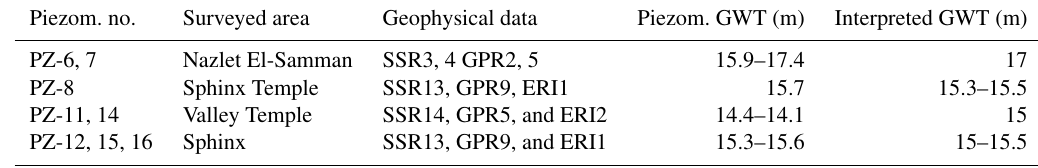
Table 4. Average interpreted groundwater elevations to the nearest eight installed piezometers (modified after AECOM, 2010). Piezom. no.